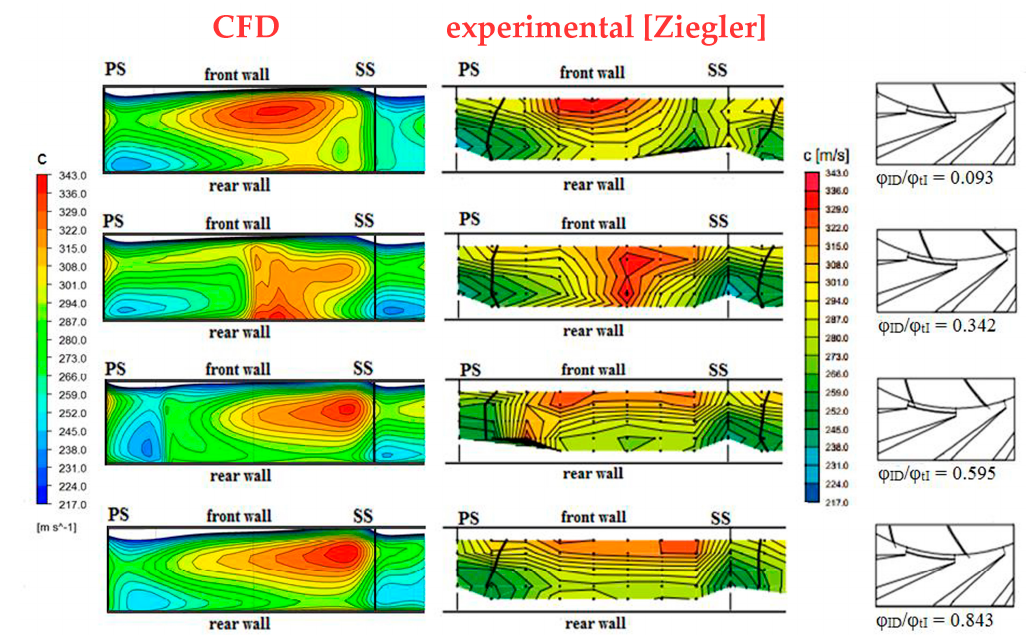
Figure 15. Unsteady absolute velocity at 2M in the absolute frame of reference, point P1, comparison between numerical results of HR-KO (left) and experimental results (right).